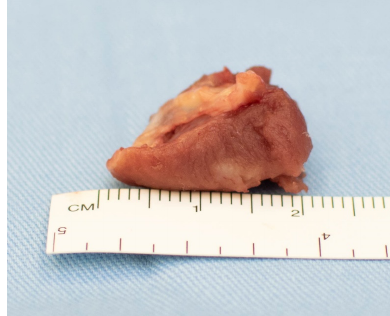
Figure 1. Septal myectomy piece.